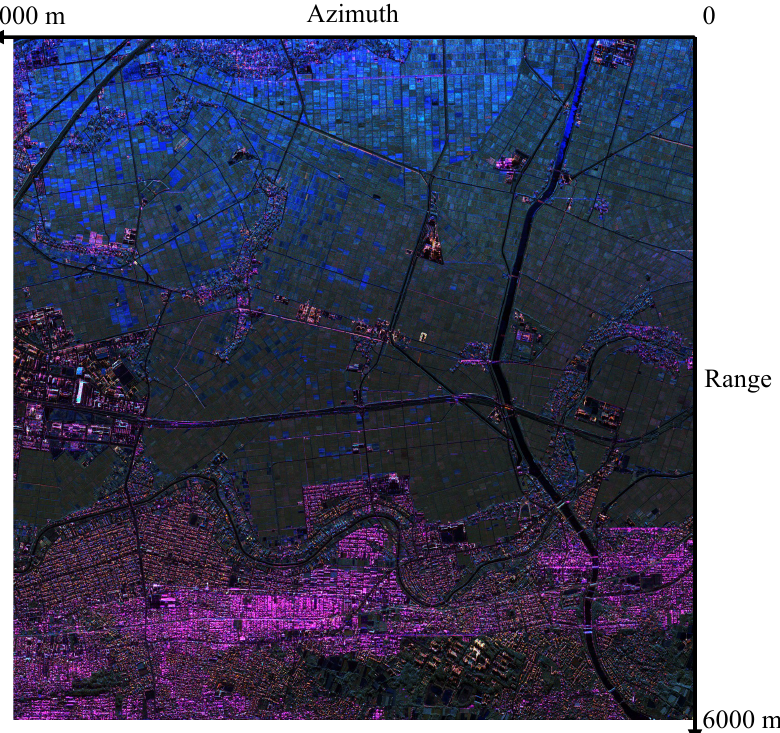
Figure 16. Another 6SD image after calibration near Niigata Univ. on 25 August 2013 (Center: N37.852,